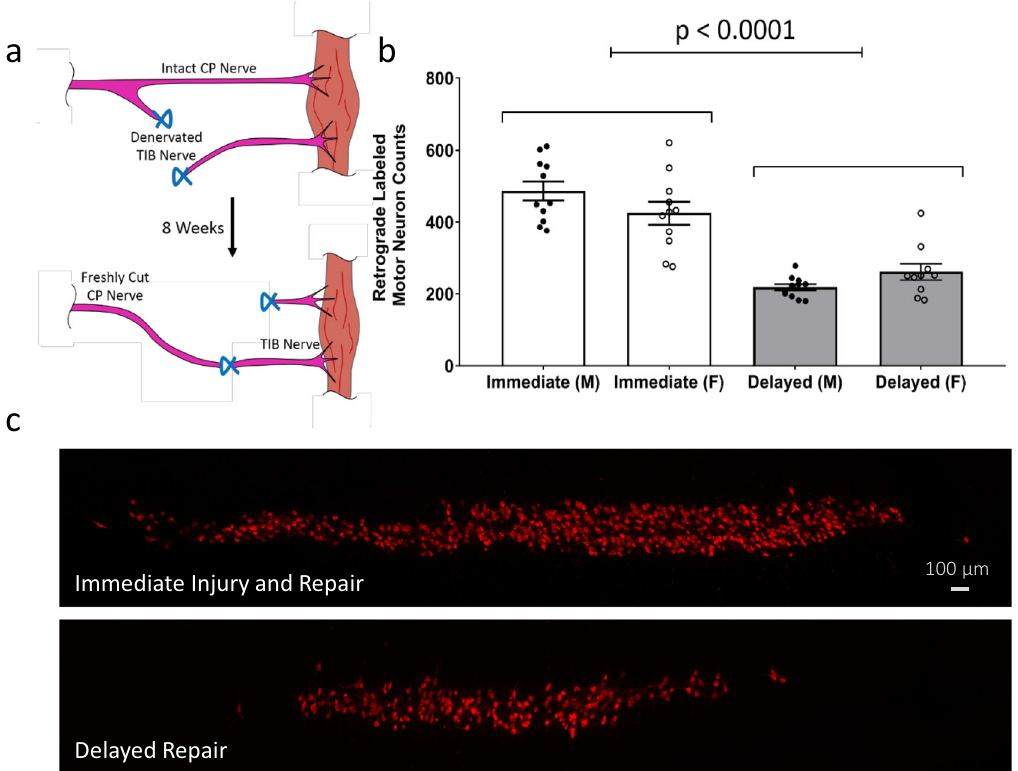
Fig. 1 Delayed repair signi fi cantly reduces recovery after nerve graft. a Experimental paradigm. Freshly axotomized common peroneal (CP) nerve branch was grafted to the acutely or chronically denervated tibial (TIB). To mimic a delayed graft, the TIB nerve branch was transected 2 – 5 mm distal to the sciatic trifurcation and sutured to the quadriceps muscle. After 8 weeks of delay, the proximal (CP) and distal (TIB) stumps were aligned and cross sutured. Immediate repair was achieved with immediate CP-TIB cross-suture. b Retrograde tracer con fi rmed signi fi cantly lower number of regenerated motor neurons in the spinal cord after delayed repair compared to immediate injury and repair in both male and female animals ( P < 0.0001, ANOVA, n = 11/group). No sex effect was observed. c Representative Z-stacks of mouse spinal cord (L4-S2) with retrograde-labeled motor neurons after delayed or immediate injury and